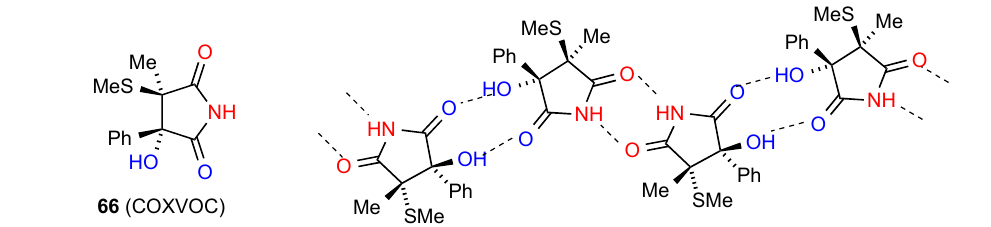
Figure 23. Structure adopted by compound 66.